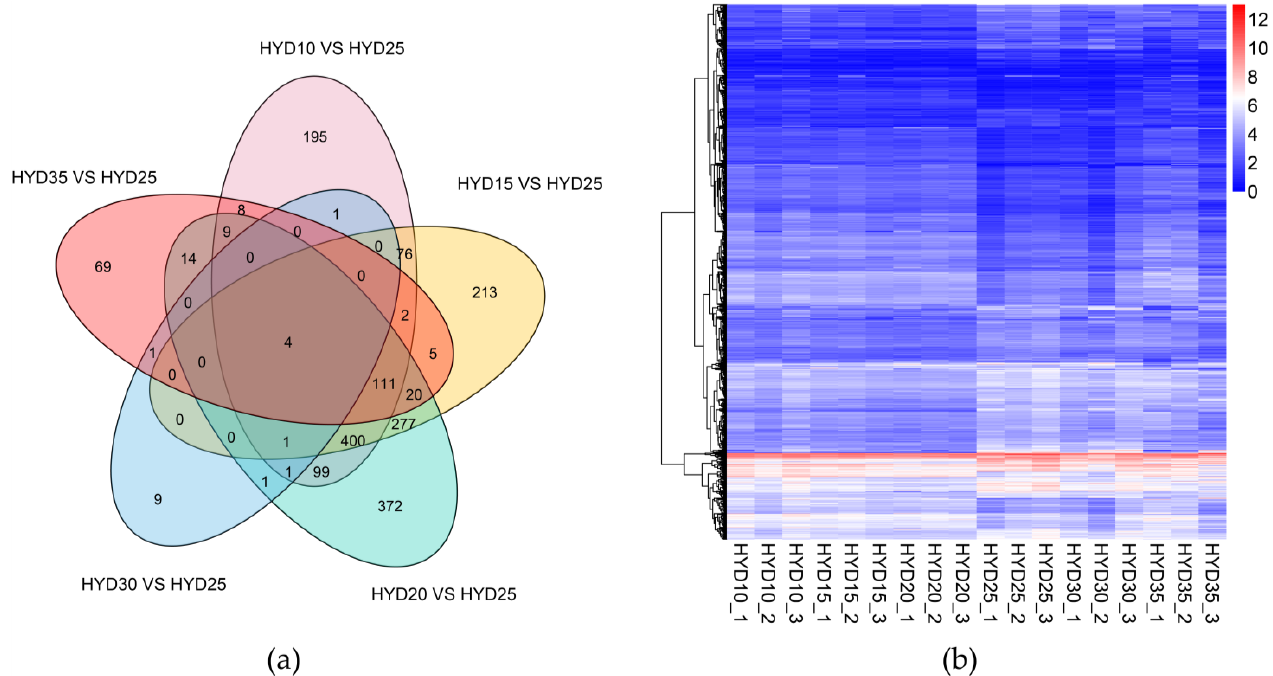
Figure 1. ( a ) The global overview of differentially expressed genes based on a Venn diagram. ( b ) Clustering heat map of differentially expressed genes. The horizontal axis represents the log 2 (FPKM + 1) of the sample, and the vertical axis represents the gene. The redder the color is, the higher the expression, and the bluer the color is, the lower the expression.